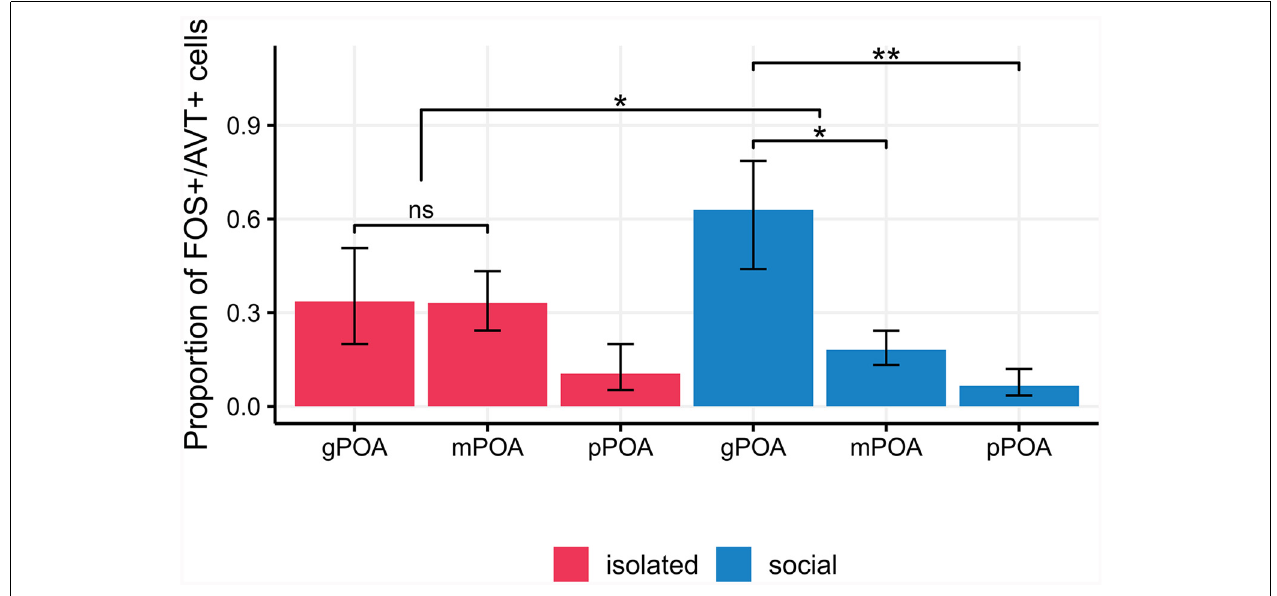
FIGURE 5 | Isolated males show no significant differences in the proportion of FOS+/AVT+ cells between the different POA cell types (pairwise p -values > 0.14). In social males, the proportion of FOS+/AVT+ is significantly higher for gPOA cells than for mPOA cells ( p = 0.02), and pPOA cells ( p = 0.003). This difference in the activation profile of gPOA and mPOA cell types between experimental conditions is statistically significant ( p = 0.03). pPOA, parvocells; mPOA, magnocells; gPOA, gigantocells. ∗ p < 0.05, ∗∗ p < 0.01, ∗∗∗ p < 0.001; ns, non-significant.